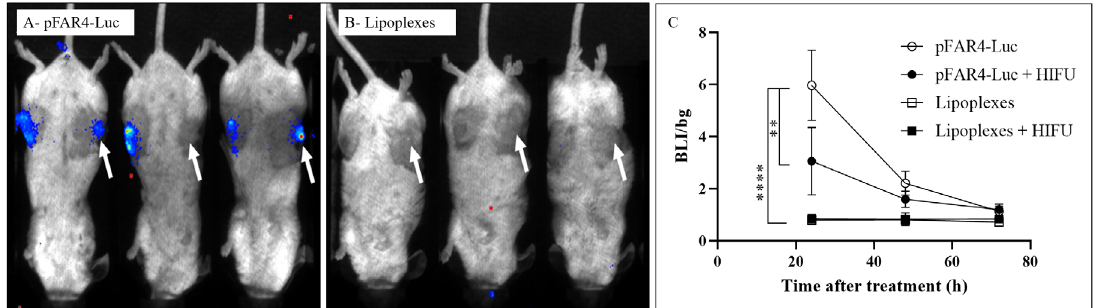
Figure 3. Representative BLI images of mice 24 h after transfection and quantitative representation of intratumor transfection. (A) CT26 tumor bearing-mice were injected intratumorally with 20 µg of free pFAR4-Luc or (B) lipoplexes composed of pFAR4-Luc and DOPE/DMAPAP/YUK1350 treated (right tumors, white arrow) or untreated (left tumors) with “HIFU 80T 30 s” protocol (1.5 MHz, 80% of amplitude, 0.1 s/pulse, and duty cycle of 33.3% for 30 s). For the BLI image, mice were injected by intraperitoneal route with 2 mg of luciferin, and the signal acquisition was performed with an intensified-charge coupled device (iCDD) camera for 10 min. (C) Luc gene expression in tumor 1–3 days after transfection with naked pFAR4-Luc or lipoplexes with or without